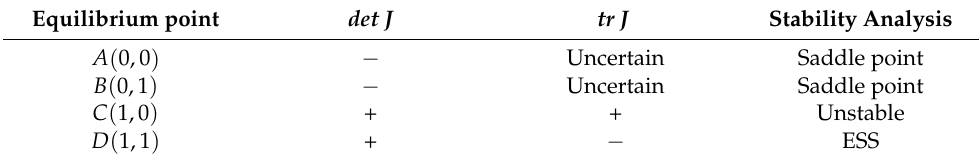
Table 7. Stable equilibrium analysis in scenario